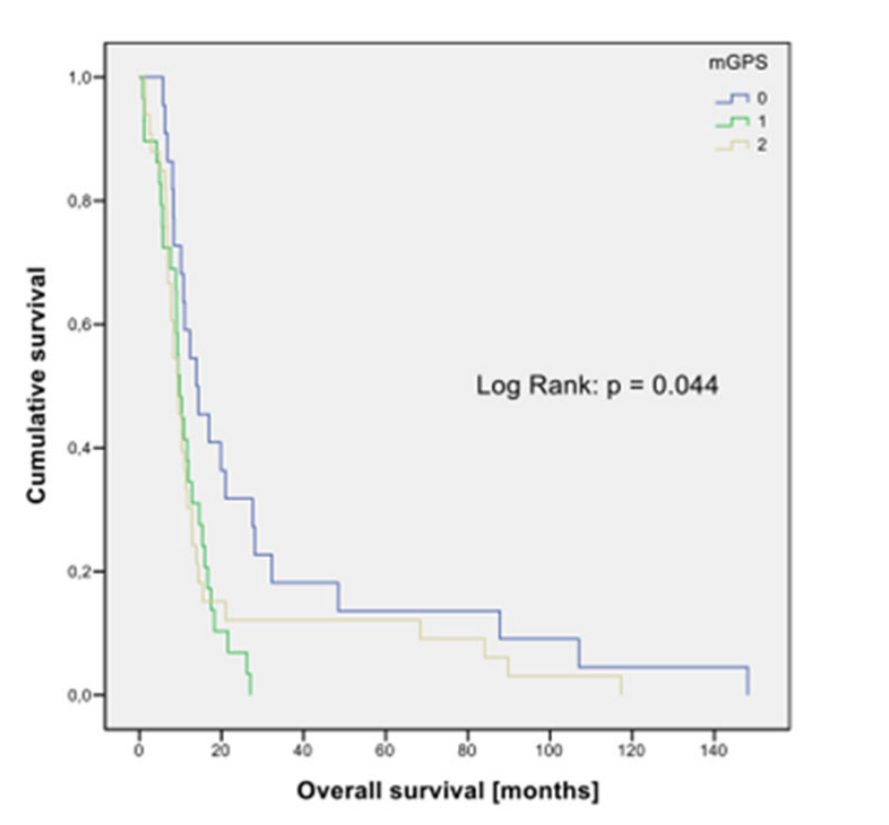
Figure 4. Kaplan–Meier graph for overall survival according to mGPS. N = 84; 0: n = 22; 1: n = 29; 2: n = 33.